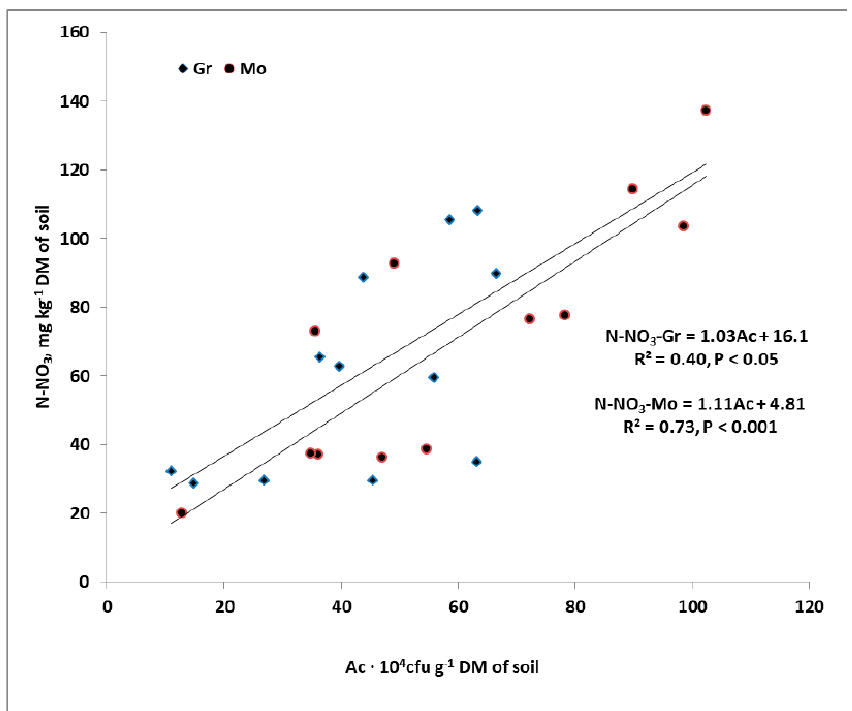
Figure 8. The impact of actinobacteria count on the content of nitrate nitrogen in two systems of pasture management. Legend: Gr–grazing system, Mo–mowing system.